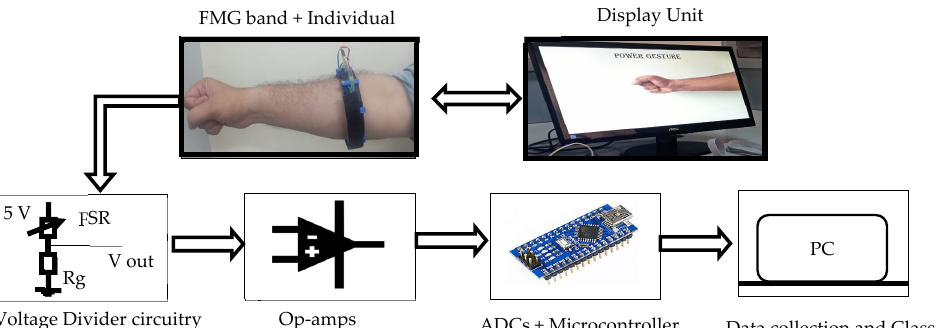
Figure 3. Flow chart of the experimental setup.